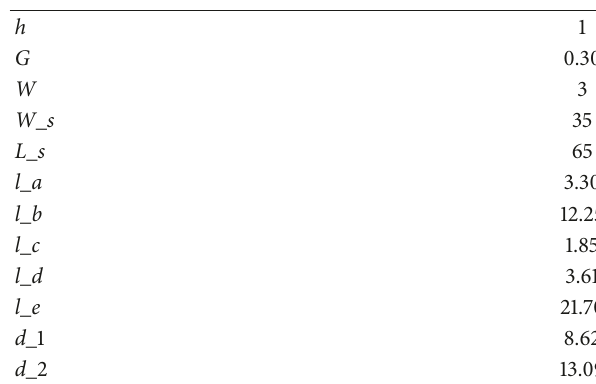
Table 1: The optimal parameters of the 1×2 linear array (unit: